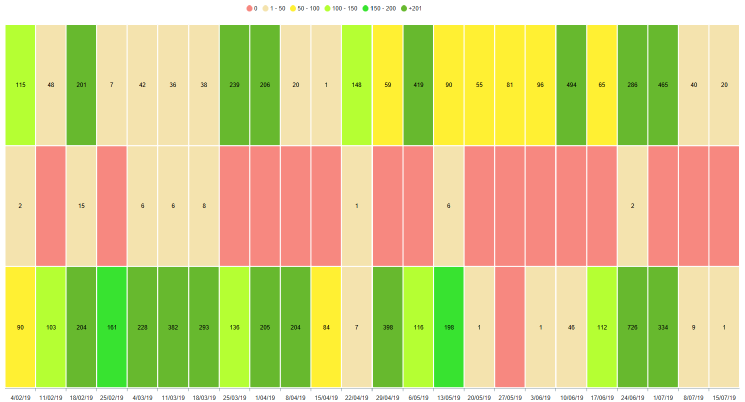
Figure 13. Heatmap of teacher